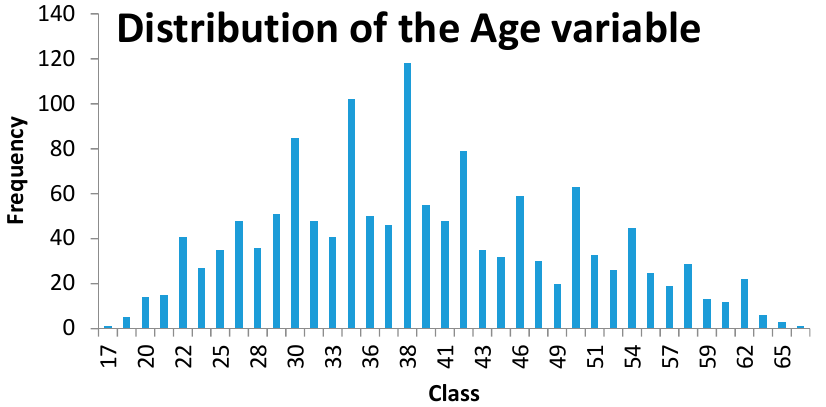
Figure 2. Distribution of the age variable. Source: Compiled by authors. Table 2. Sample distribution by age. Source: Compiled by authors.